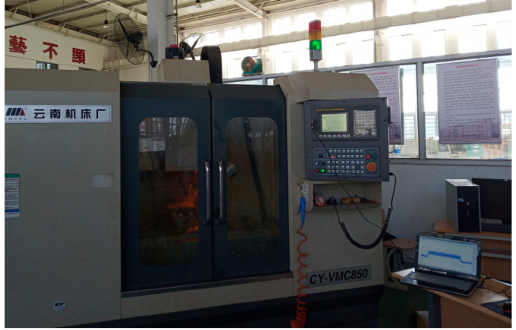
Figure 8. Tool wear condition recognition roadmap based on current signal analysis.